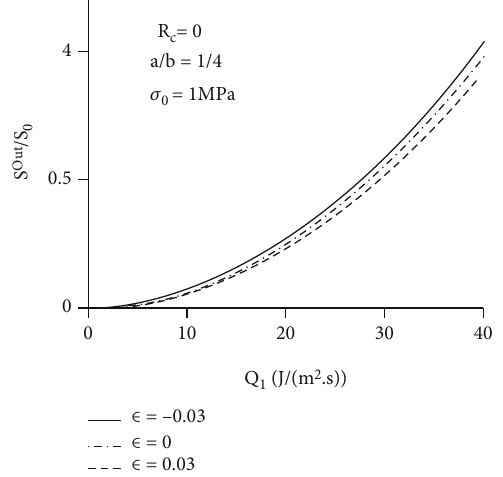
ε = − 0 : 03, 0, 0 : 03 for R